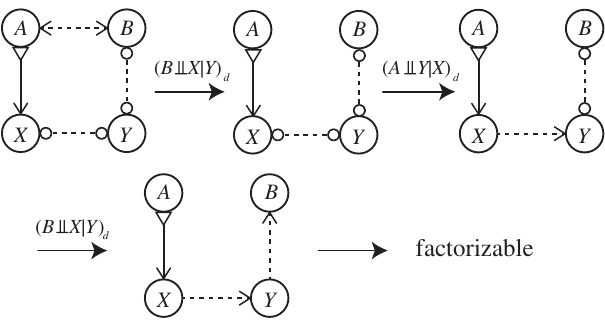
FIG. 12. Elimination of DAGs in step 3.